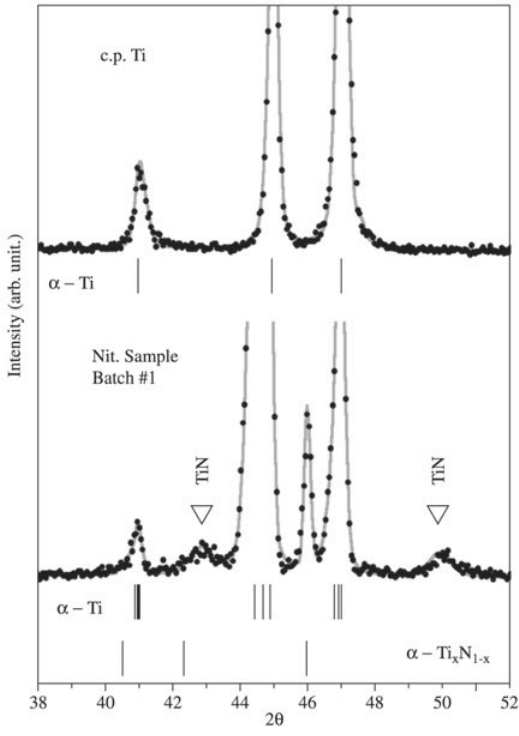
Figure 7. Rietveld analysis (solid line) of XRD patterns (experi- mental points) for c.p. Ti and nitrided sample. The a-Ti, a-TiN reflections are indicated by vertical bars. Those for TiN and indi- cated by triangles.